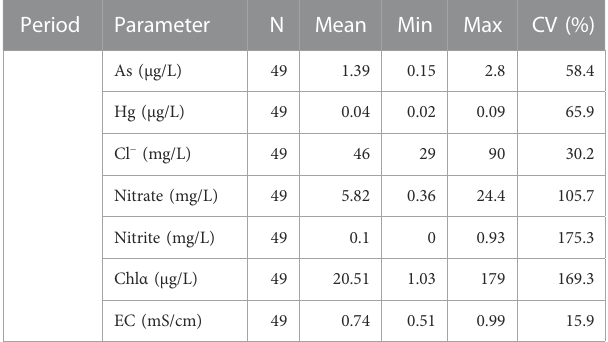
TABLE 1 Temporal changes of the physicochemical parameters in the study